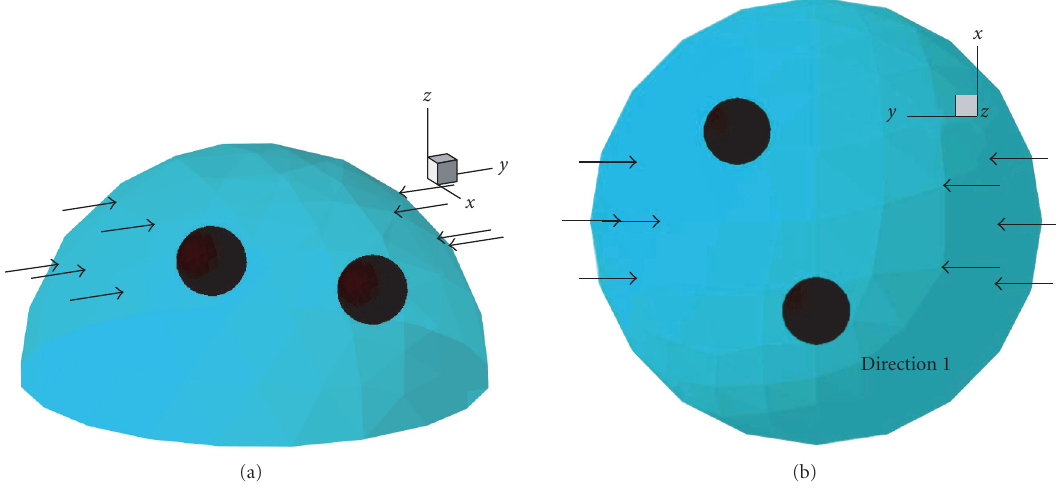
Figure 3: Loading 1: compression nodal force applied on the surface of Phantom II. (a) 3D view; (b) x - y plane view to show direction 1.